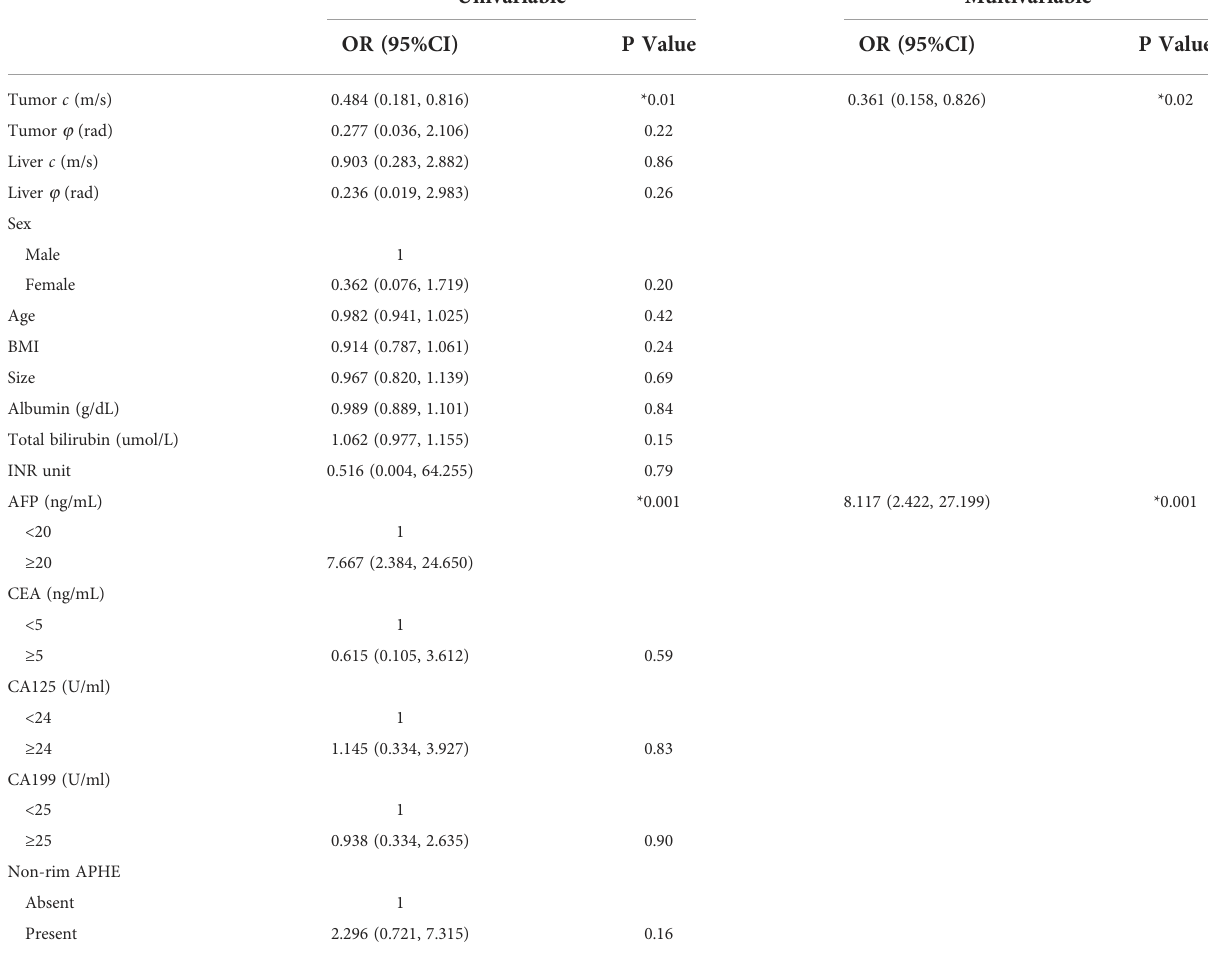
TABLE 4 Univariate and multivariate analyses of variables associated with GPC3-positive HCC. Univariable Multivariable OR (95%CI) P Value OR